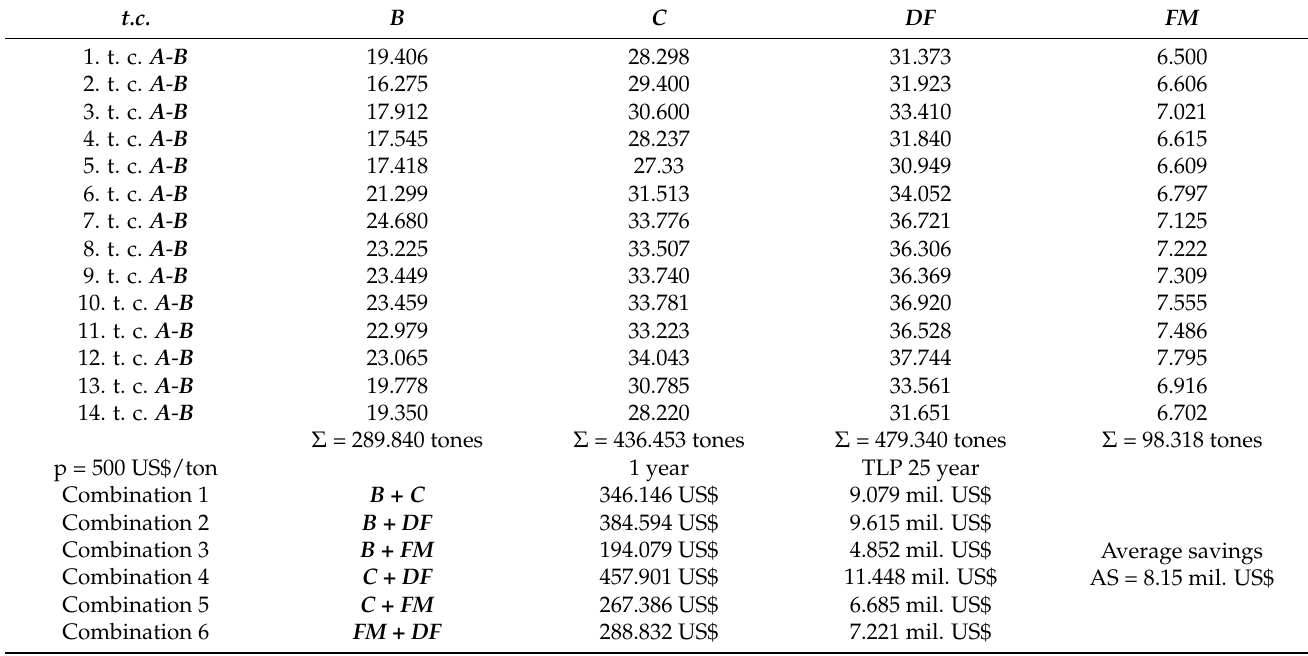
Table 3. Savings for various combinations of cargo in the event of total transport engagement.